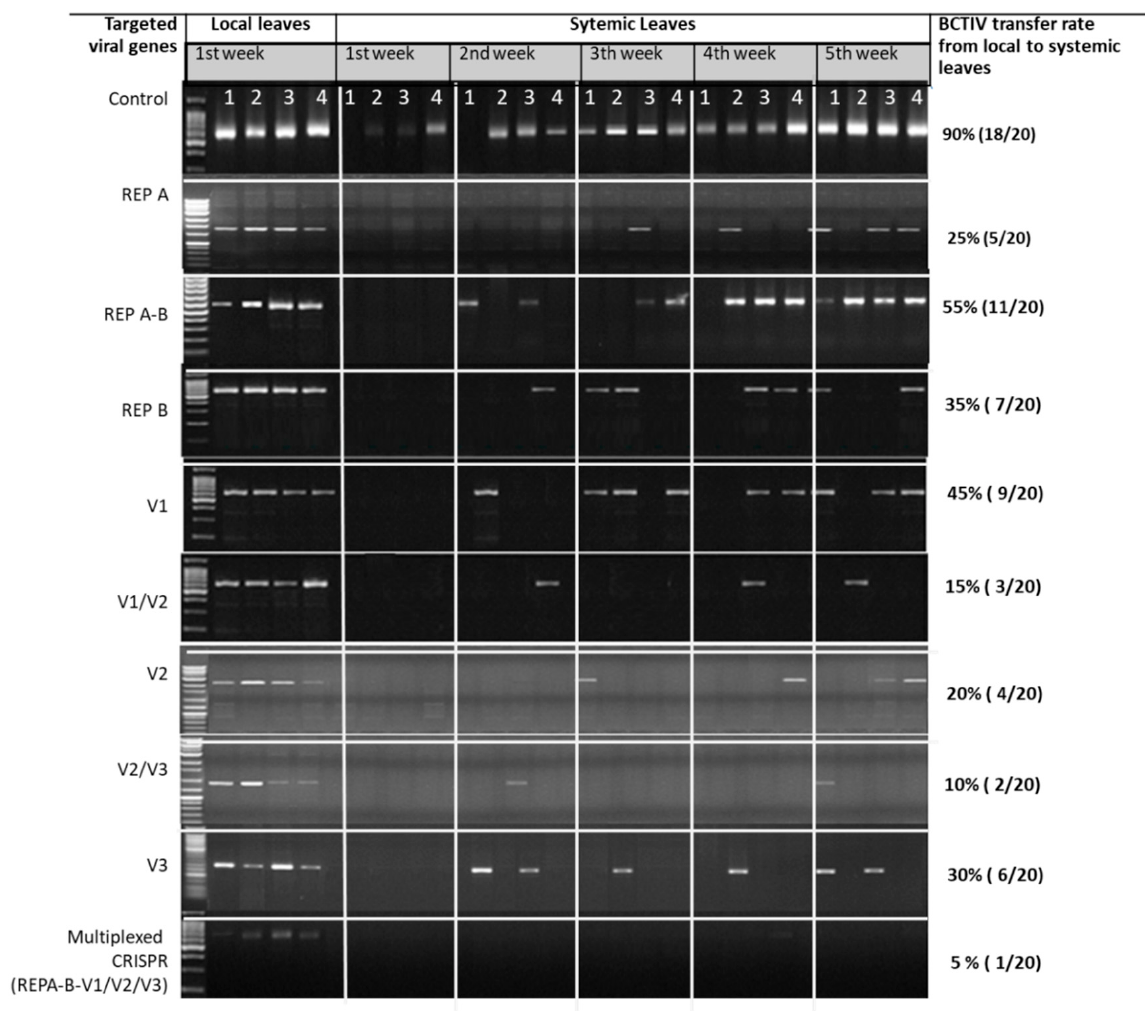
Figure 2. The results of RCA assay in local and systemic leaves of sugar beet co-agroinoculated with BCTIV and gRNA/Cas9. The rate of RCA fragments revealed by the RCA assay was used as an indicator for BCTIV systemic infection from local to systemic leaves. The PCR bands on the gel electrophoresis indicate the whole-length genome of BCTIV (~2840 nt) produced by the RCA reaction in local and systemic leaves of sugar beet. Twenty sugar beets were co-agroinoculated with BCTIV and CRISPR constructs and viral movement from local to systemic leaves were fallowed for five weeks by RCA assay. For each week four plants were harvested for DNA isolation and biomass measurements. The viral transfer was measured as the ratio of RCA products obtained from systemic leaves of sugar beets.